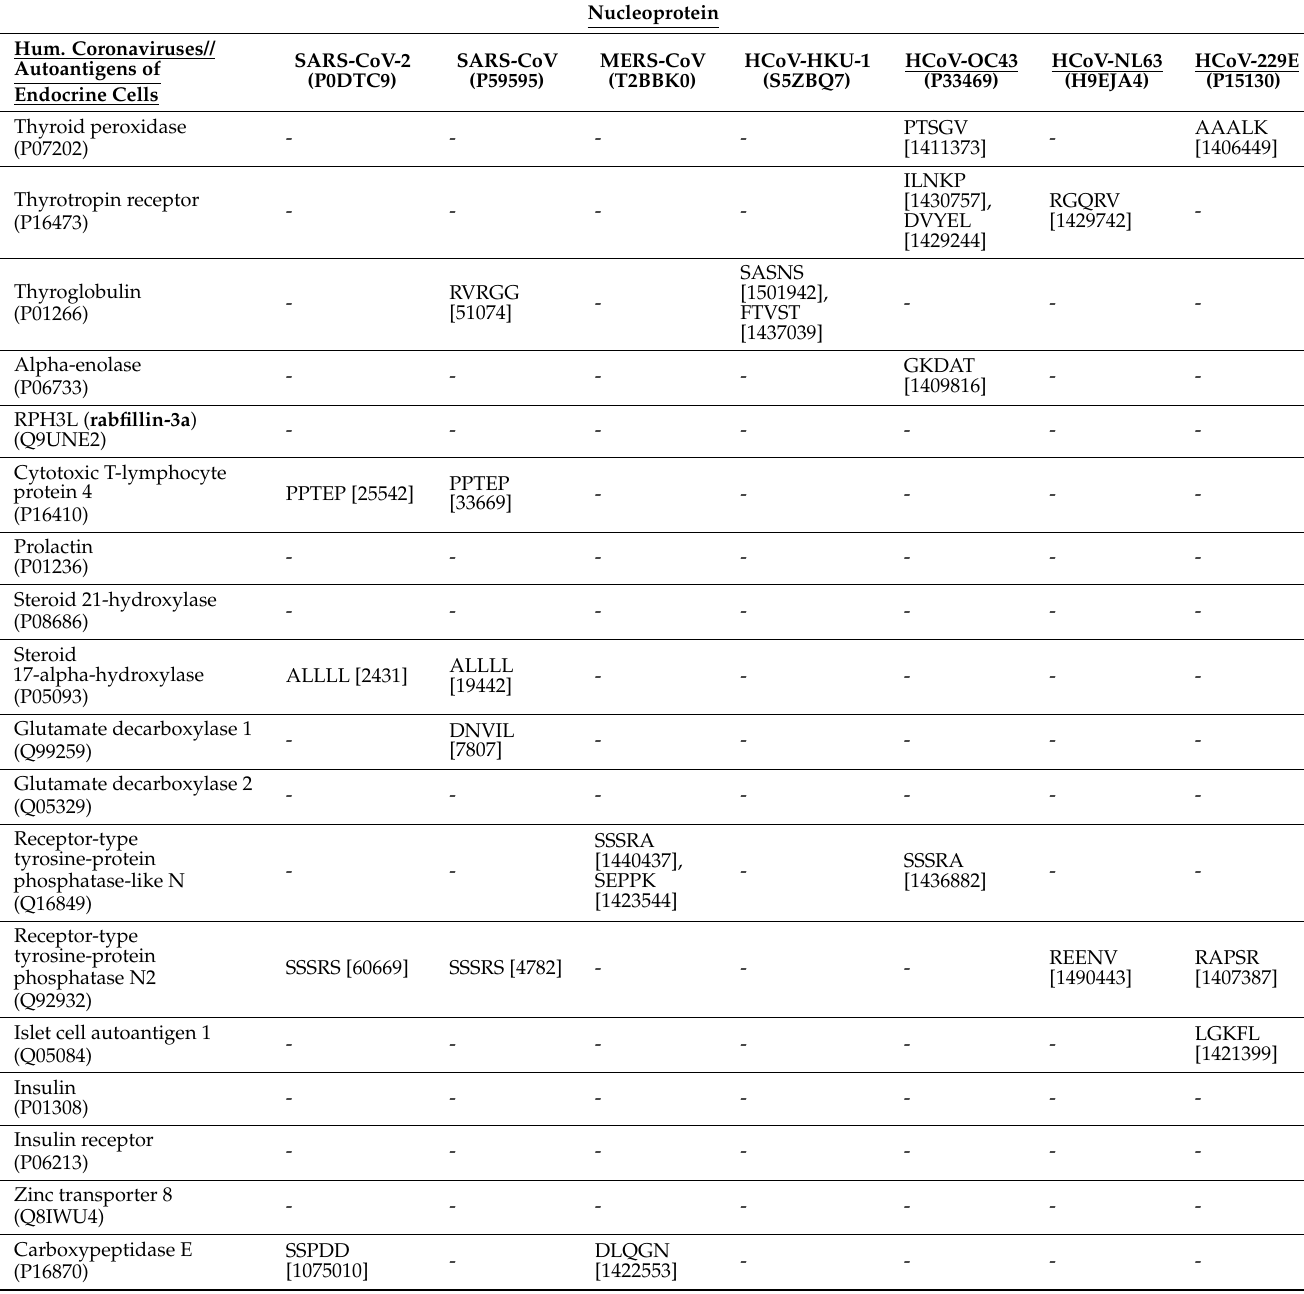
Table 3. Nucleoproteins of human coronaviruses and autoantigens common for autoimmune en- docrinopathies: shared pentapeptides. ID numbers of immunoreactive epitopes from the Immune Epitope Data Base for Human Coronaviruses nucleoproteins are shown in the square brackets for each